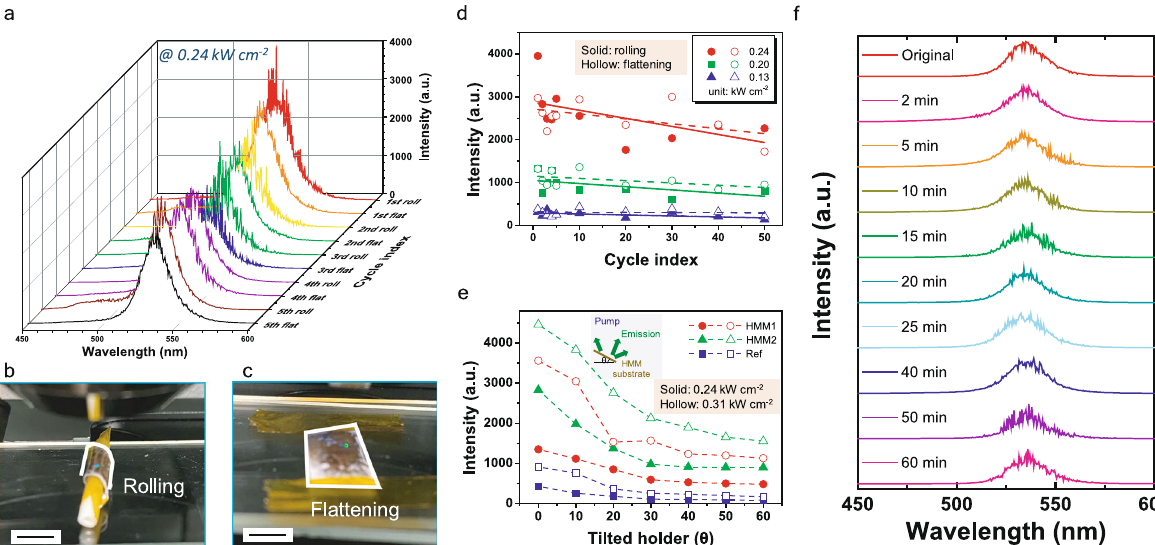
Fig. 6 Functionalities of the fl exible and rollable HMM device. a The emission spectra of random lasing action for the HMM2 device with increasing cycle index at the pumping energy density of 0.24 kW cm − 2 . The photo image of the rollable HMM assisted by a wood stick with a diameter of 1 mm (yellow color) b under rolling and c fl attening. Scale bars represent 3 mm. d The emission intensities of random lasing action of repeated rolling- fl attening processes up to 50 times under the pumping energy density of 0.24, 0.20, and 0.13 kW cm − 2 . The solid straight line is the fi tted results for the rolling state and the dash straight line is for the fl attening state. e The emission intensities measured from normal to tilted sample holder of 60° under the pumping energy density of 0.24 and 0.31 kW cm − 2 . Inset is the schematic diagram of the measuring process for the tilted sample holder. f The lasing spectra with laser expose of PNCs on HMM2 substrate for continuously 60 min at the pumping energy density of 0.24 kW cm − 2